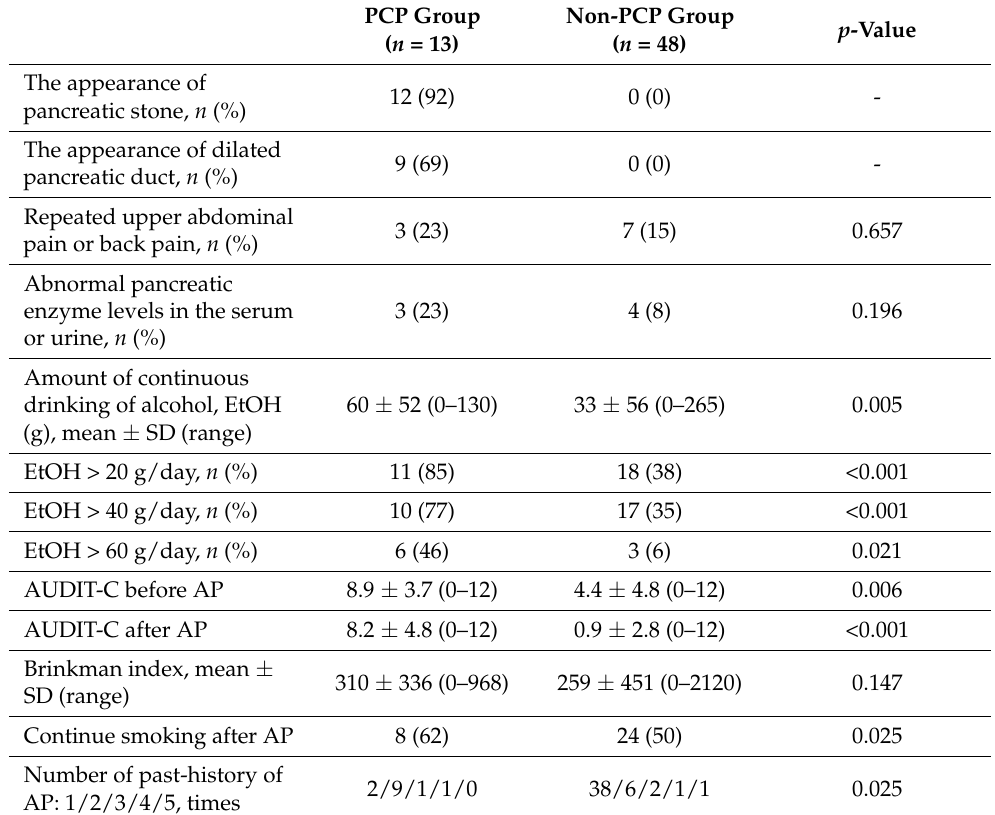
Table 3. Analysis of clinical signs related to